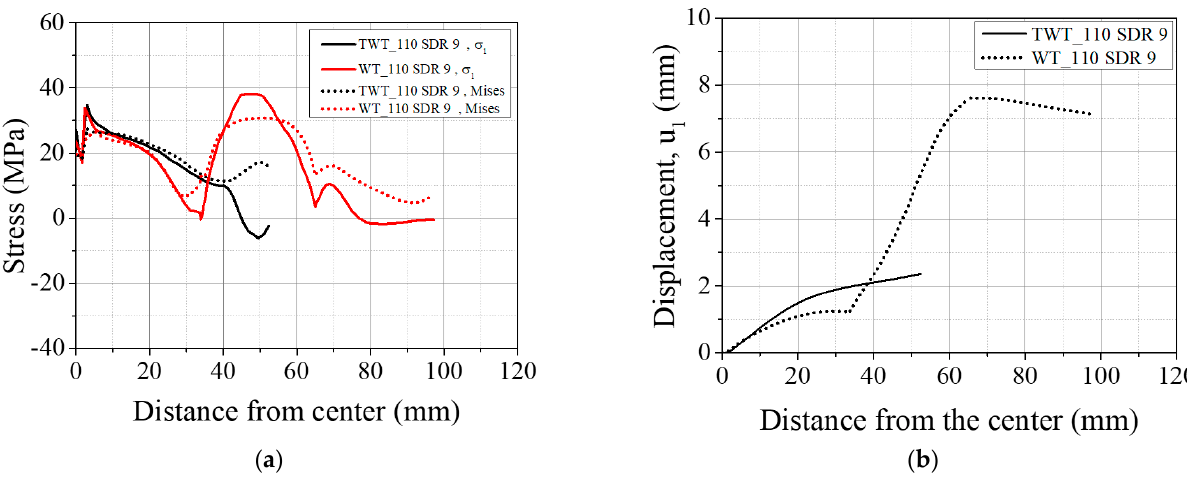
Figure 15. FEA results of Type A, 110 SDR 9 TWT and WT specimens at F max : ( a ) σ v and σ 1 ; ( b ) u 1 .